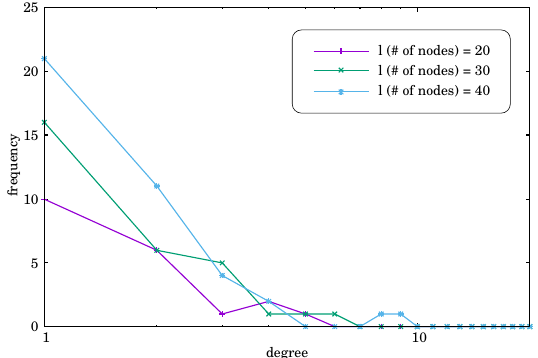
Figure 4. The hierarchically dependent function (HDEP).